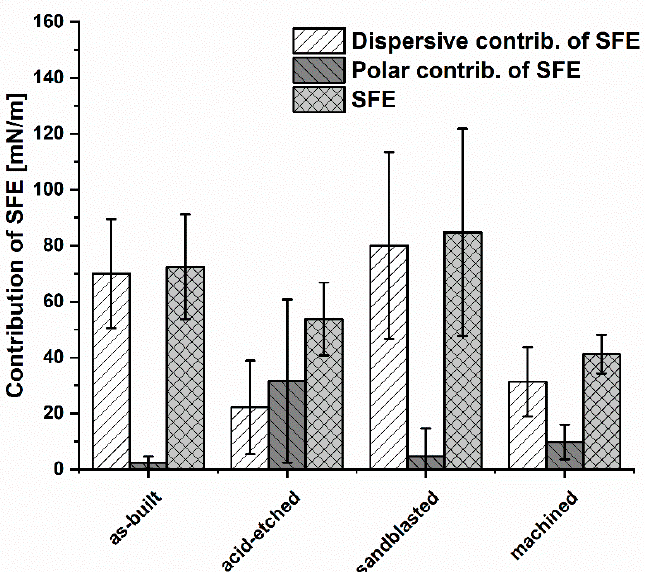
Figure 8. The contribution of polar and dispersion components in SFE and SFE values for the analyzed materials (average values and standard deviation).